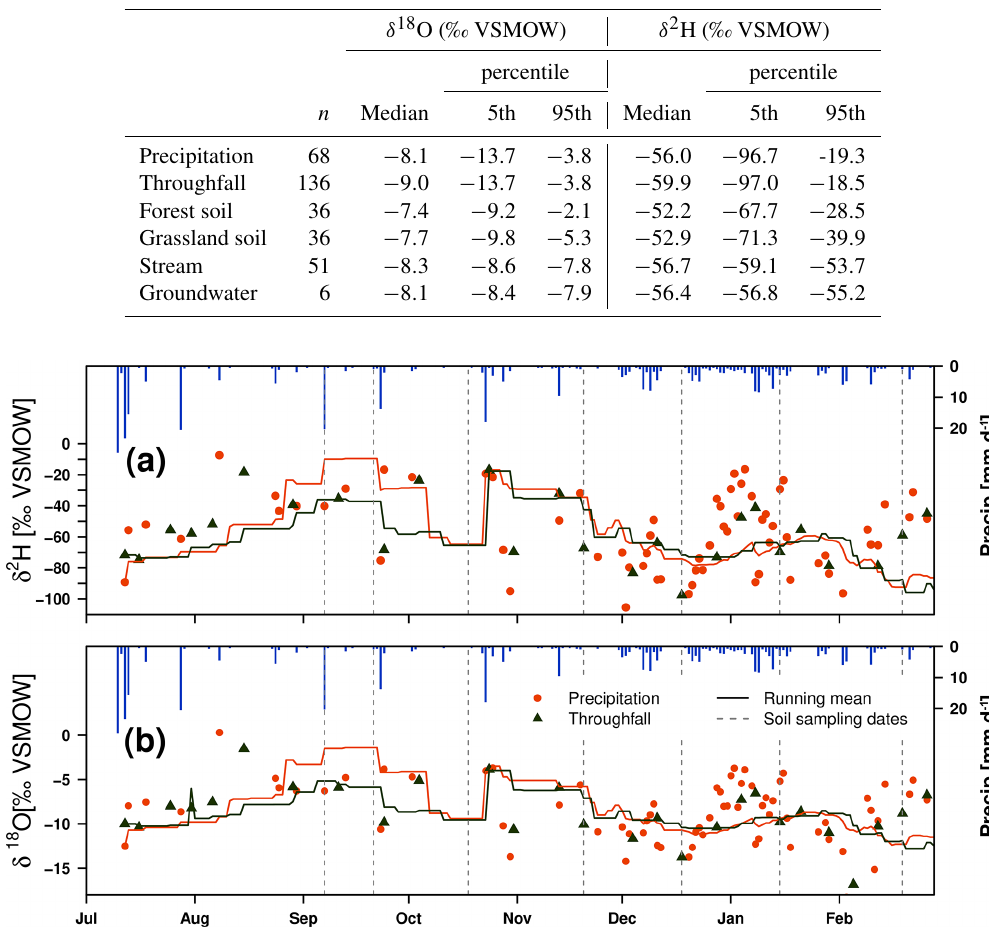
Figure 4. Time series of daily precipitation amount and isotopic signature of weekly throughfall at forest A and daily precipitation and their 30d running (volume-weighted) mean for δ 2 H (a) and δ 18 O (b) , with dotted lines indicating dates of bulk soil water sampling (dashed